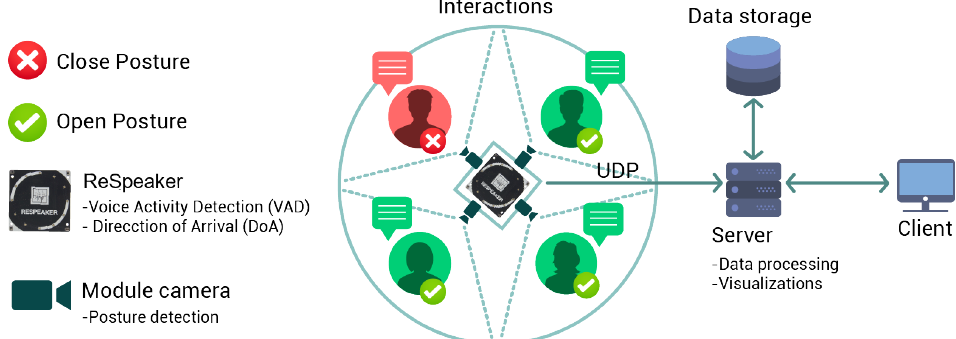
Figure 1. High level architecture of the developed